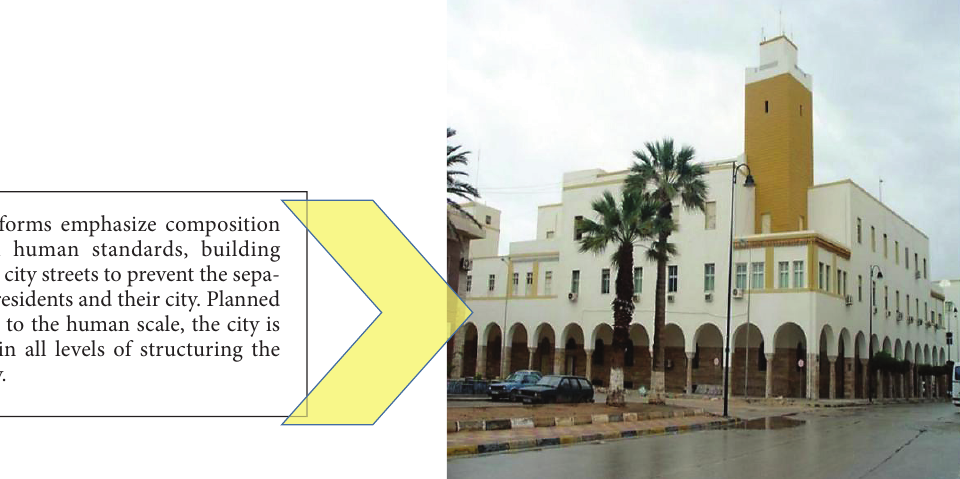
Figure 9. Th e view is attracted by a glimpse of a corner of a “public building” (Harby,